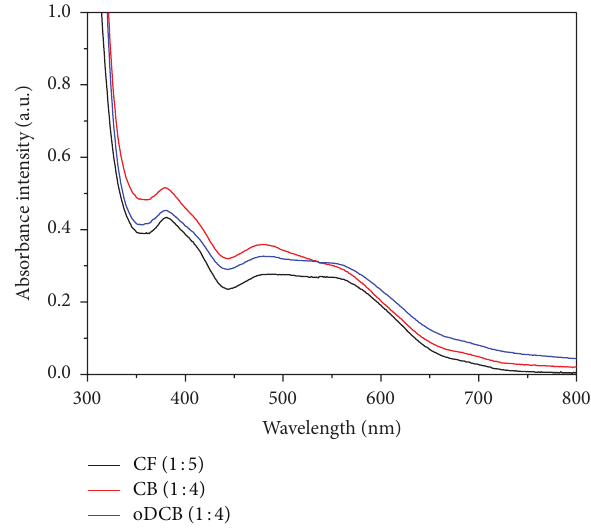
Figure 4: Surface roughness values obtained from the AFM images for PCDTBT:PC 71 BM films prepared with organic solvents of chloroform (1wt%), chlorobenzene (2wt%), and o-dichlorobenzene (3wt%).